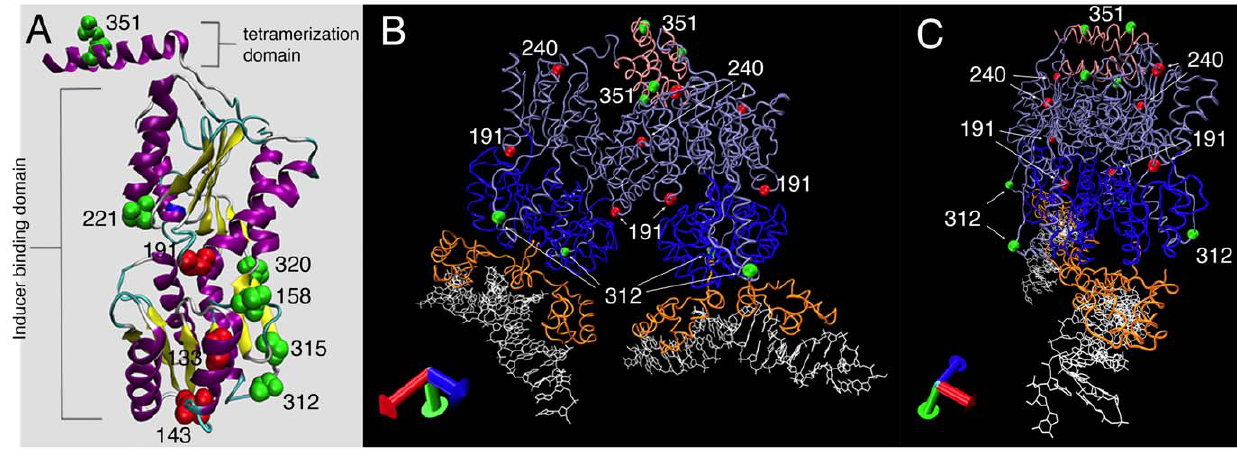
Figure 4. Cartoon of LacI-GFPi proteins mapped onto the crystal structure of LacI. (A) The monomeric structure of LacI without the DNA binding domain (PDB ID: 1LBI). All LacI-GFPi proteins that localize as foci were mapped onto a ribbon representation of the LacI crystal structure. The amino acid corresponding to the site of GFP insertion is labeled and represented as a space-filling model. Red amino acids correspond to insertion proteins that are unable to repress the lac operon and green amino acids correspond to insertion proteins that retain some level of repression activity. (B) Model of the LacI crystal (PDB ID: 1LBG) structure including the DNA (white), DNA binding domain (orange), N-terminal core domain (blue), C-terminal core domain (light purple), and tetramerization domain (pink). The most active GFP insertion (LacI-312-GFPi) and LacI-351-GFPi are shown as green balls and two examples of inactive GFP insertions as red balls. (C) Same as in (B) but rotated to show the projection of amino acid 312 from the